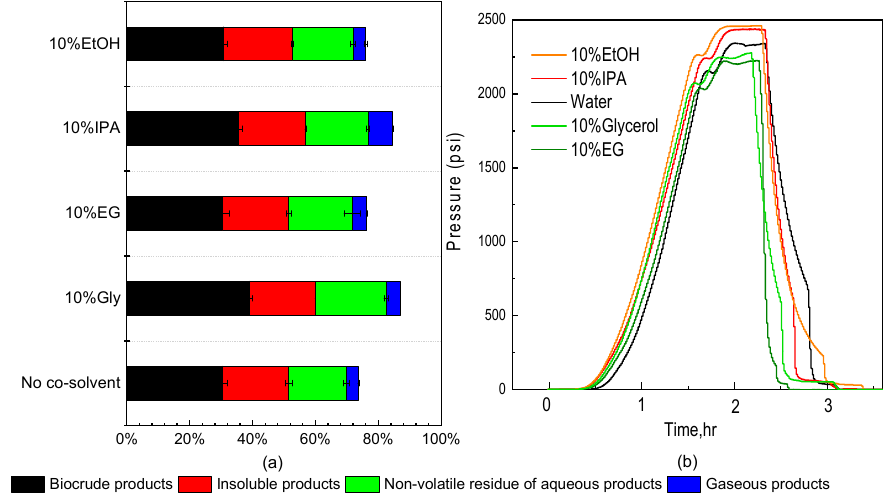
Figure 2. Effects of co-solvents on product yields ( a ) and reaction pressures ( b ) during liquefaction of Tetraselmis sp. at 350 °C (IPA: Isopropyl alcohol; EG: Ethylene glycol; EtOH: Ethanol; GLY: Glycerol). Error bars represent standard deviations from duplicate experiments.